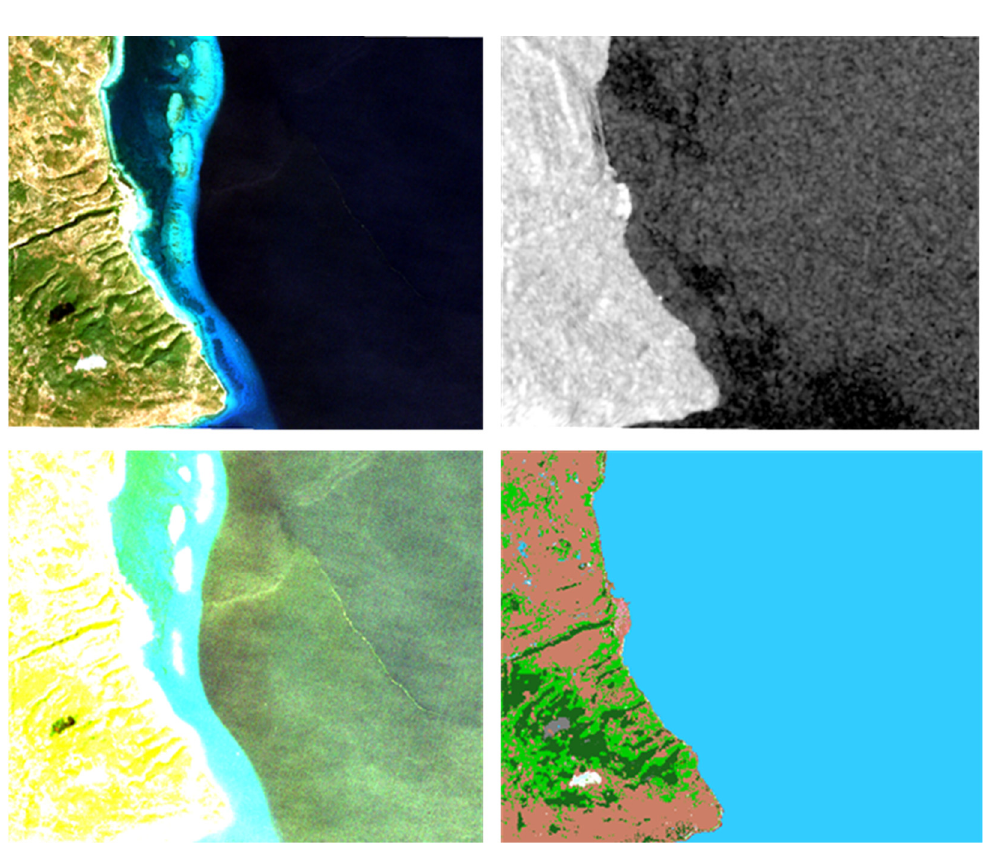
Figure 10. Comparison of the Sentinel-2 pseudo-true colour image ( top left ), SAR backscatter input ( top right ), stretched Sentinel-2 pseudo-true colour image to show the windrow ( bottom left ) and classification output ( bottom right ) for the Haiti site.